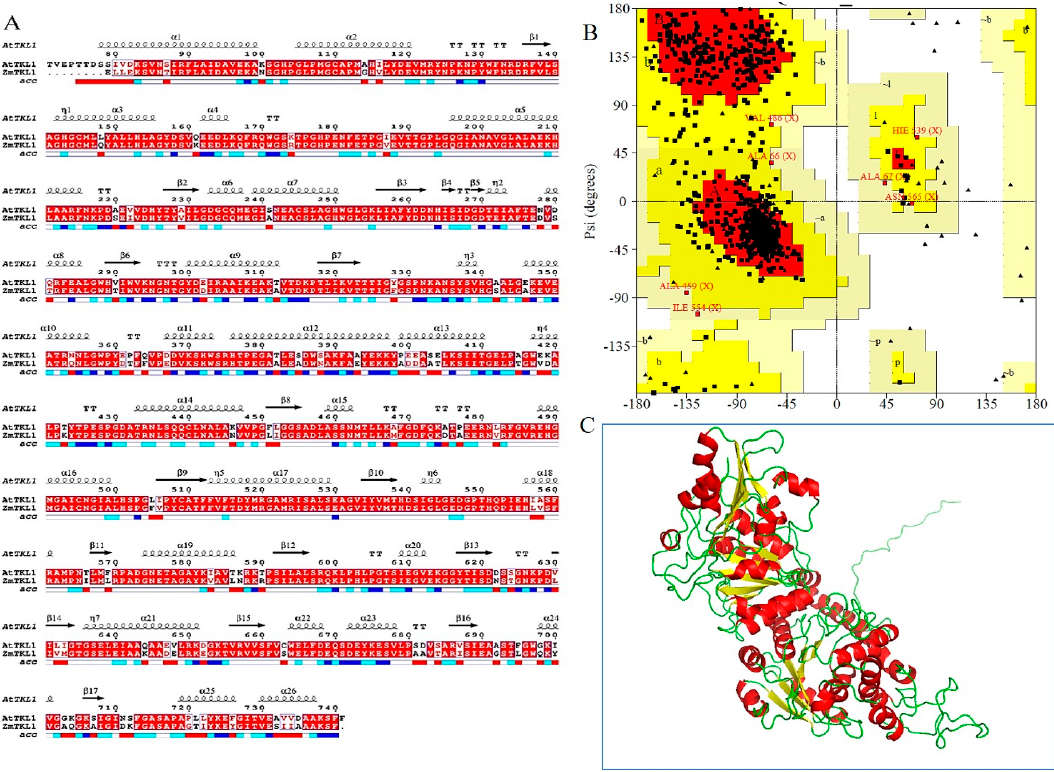
Figure 1. The bioinformatics analysis of transketolase. ( A ) Structure alignment between AtTKL1 in A. thaliana and ZmTKL1 in Zea mays ; ( B ) Ramachandran Plot of the protein after structural refinement; ( C ) Refined structure of the AtTKL1 protein, where helix is shown in red, yellow indicates beta sheets, and coil is shown in green color.